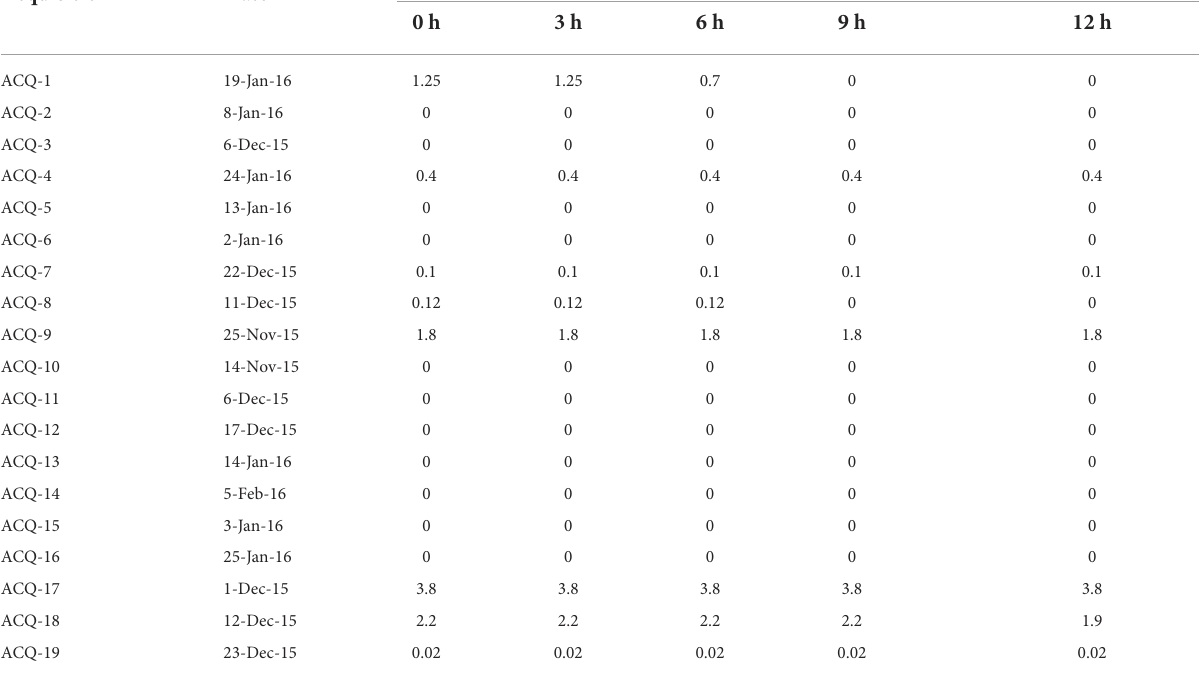
TABLE 2 Cumulative rainfall data of all PolInSAR pairs before